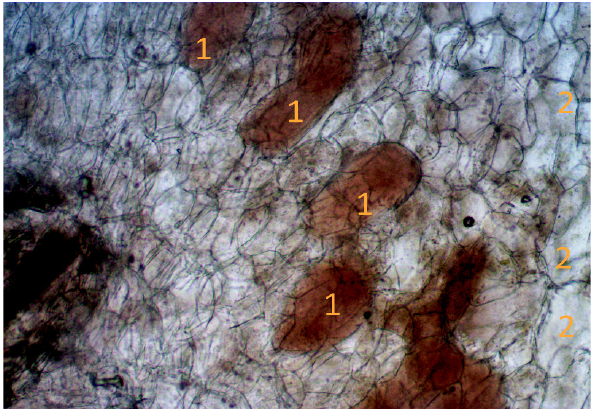
Figure 7. Cross section of the root nodule. Note: 1—zone with infected cells; 2—zone with uninfected cells. Scale: 1 cm = 100 microns.